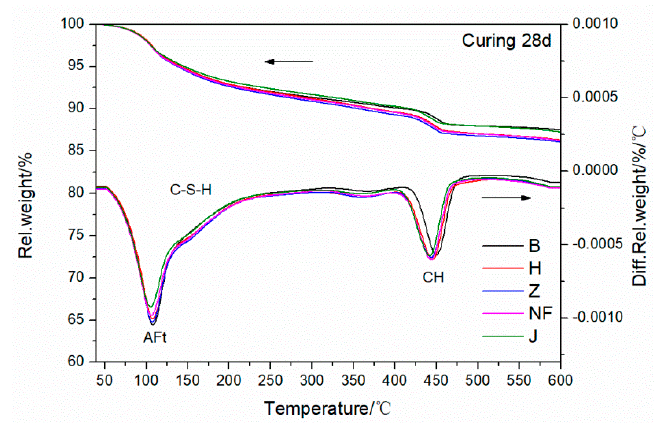
Figure 7. Effects of different superplasticizers on cement hydration after 28 days.